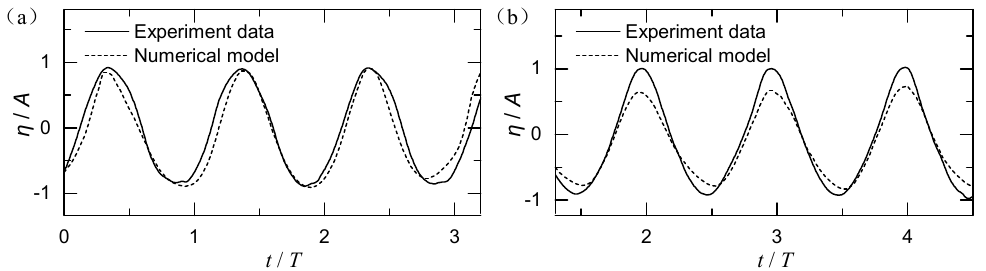
Figure 4. Comparison of the simulated and measured surface elevation recorded in test 5, ( a ) Wave gauge II and ( b ) Wave gauge III.